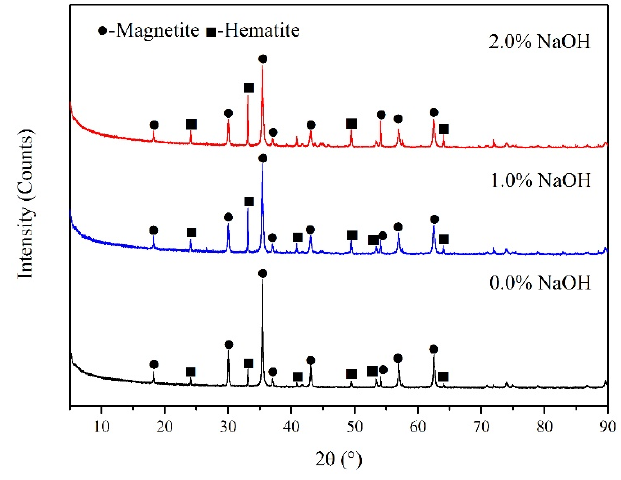
Figure 4. XRD patterns of reduction products with different NaOH content at 560 °C.